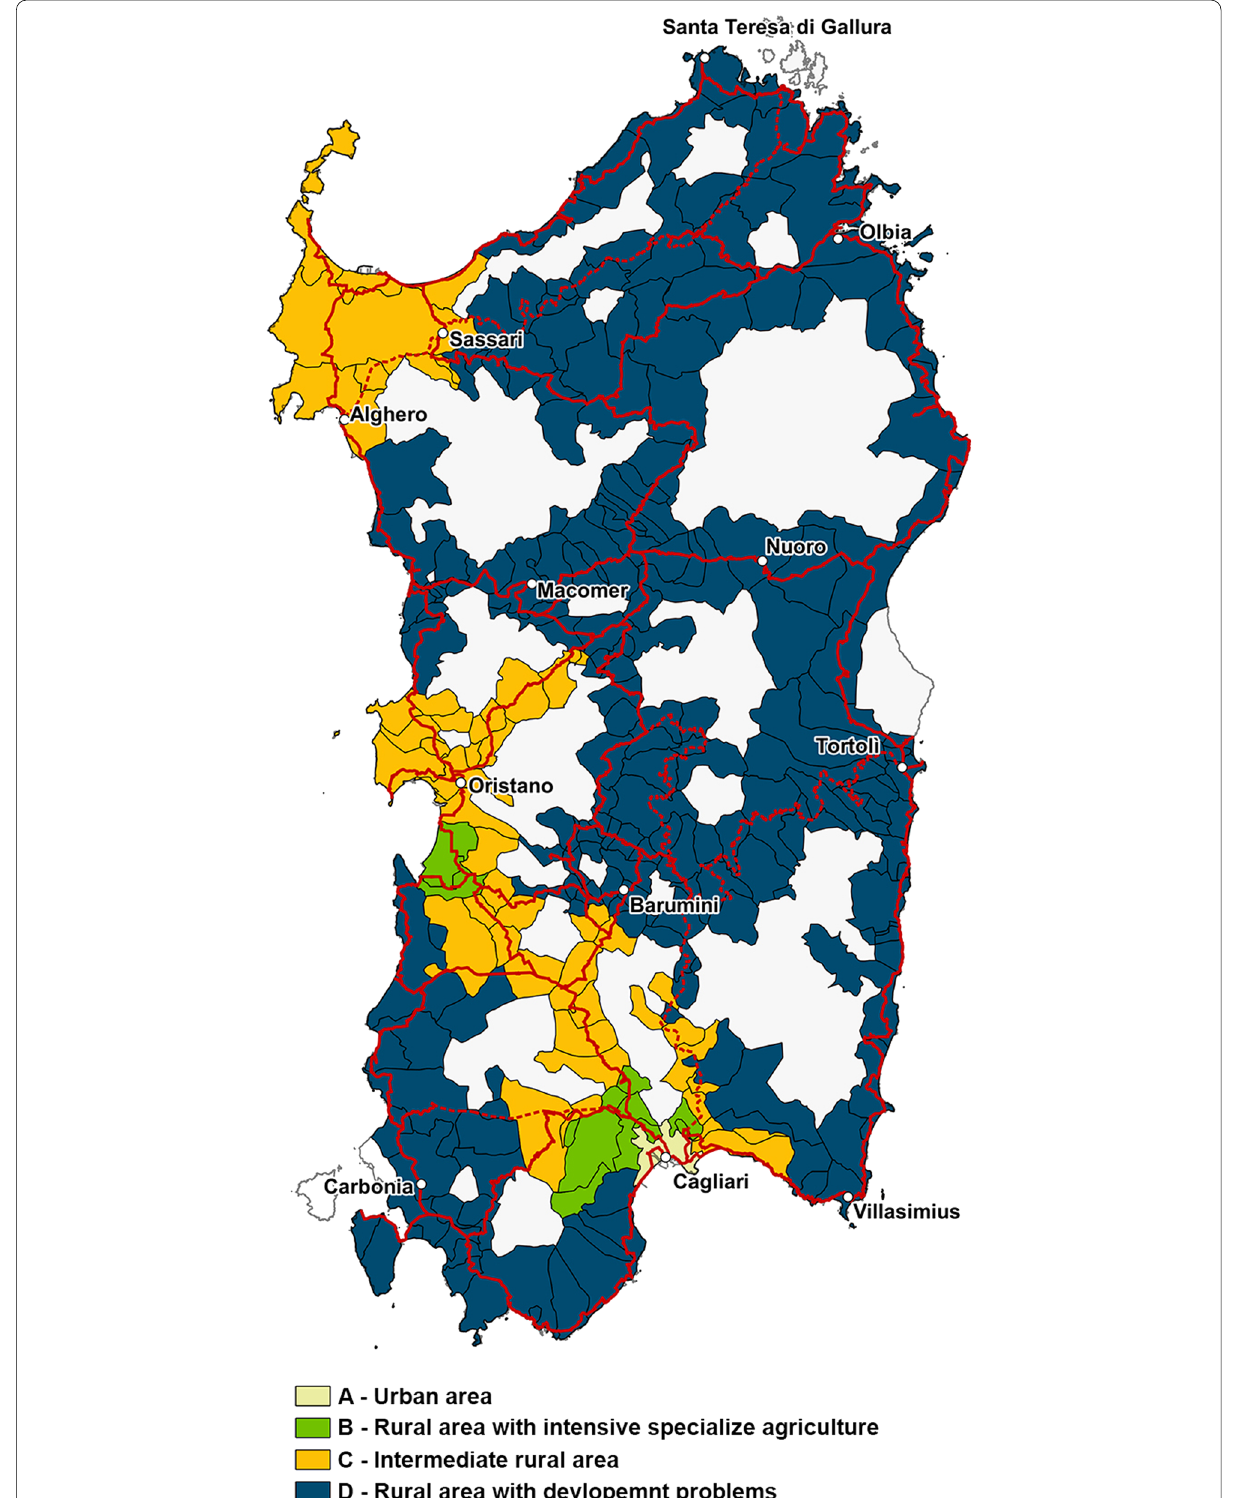
Fig. 9 Types of municipalities crossed by the cycle network according to the OECD